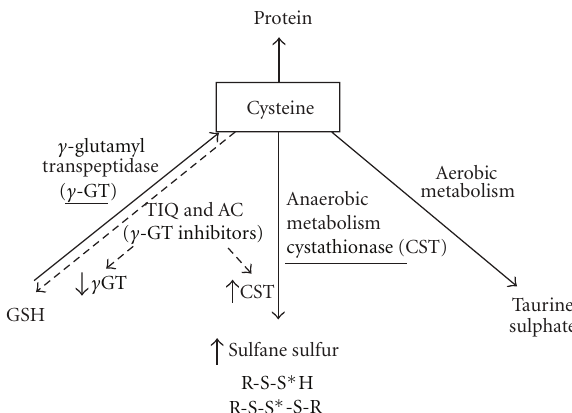
Scheme 3: Pathways of cysteine metabolism and putative e ff ects of γ GT